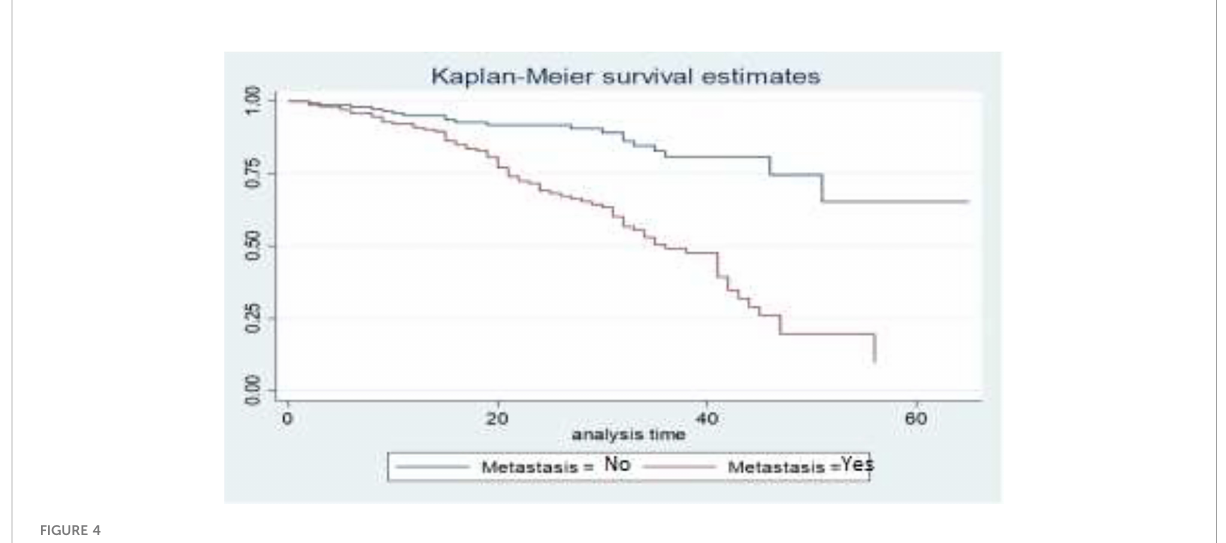
FIGURE 4 Survival curves of metastasis